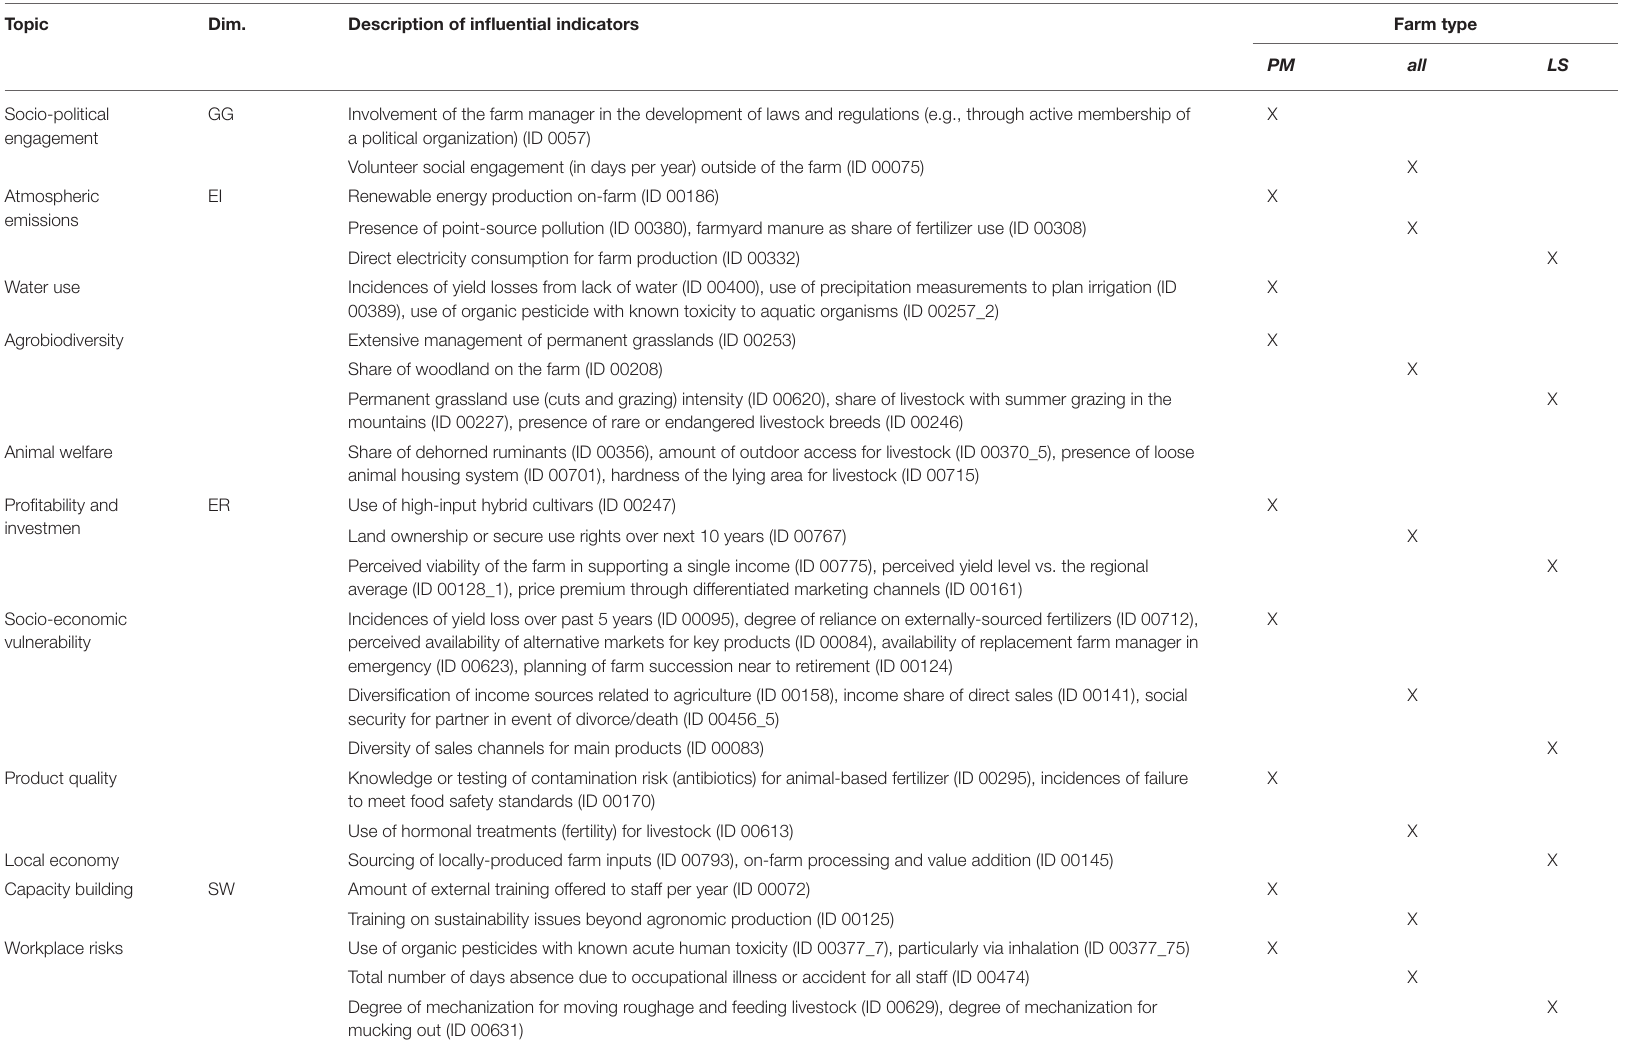
TABLE 2 | Farm management topics reflected by the final sets of selected influential indicators, arranged by farm type (final three columns). Topic